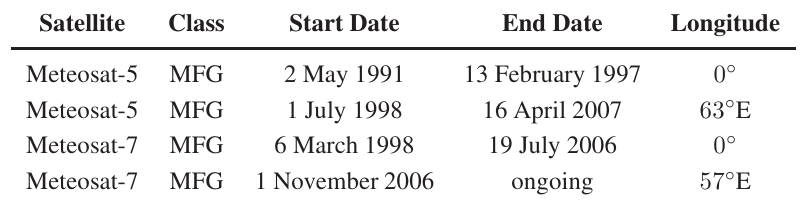
Table 1. List of relevant Meteosat meteorological satellites, with their active